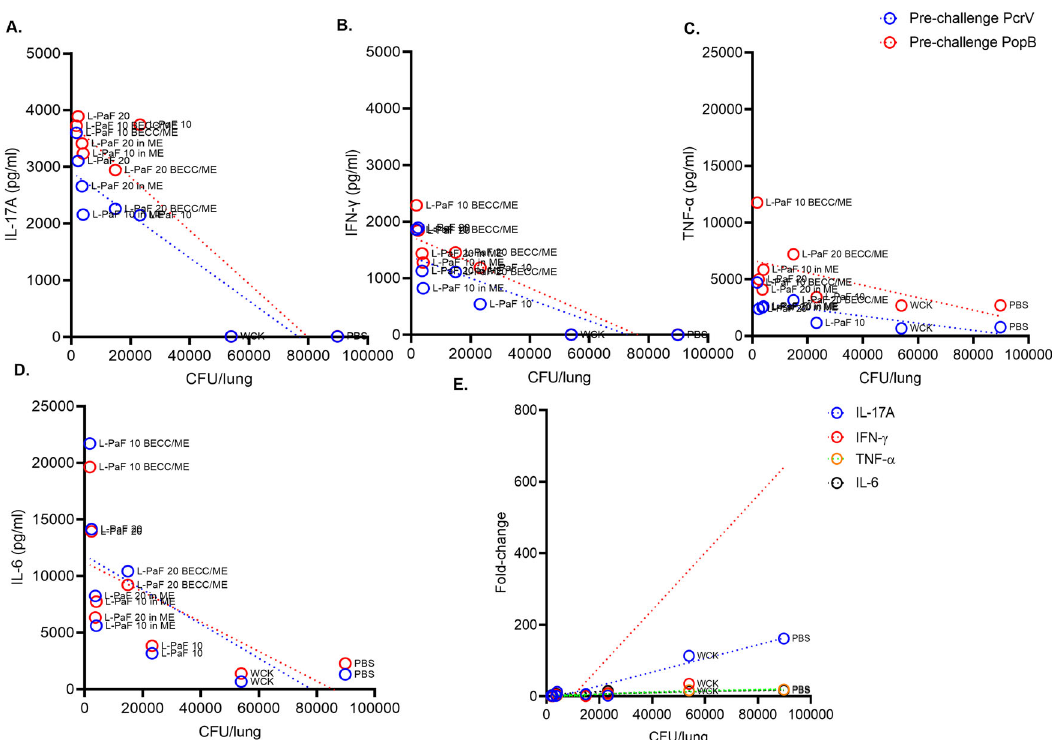
Fig. 5 Correlation between lung burden and lung cytokines. Cytokine determination assays were performed to allow for identi fi cation of potential correlations between Pa lung burden and PcrV- or PopB-stimulated pre-challenge lung cytokines (IL-17A ( A ), IFN- γ ( B ), TNF- α ( C ) and IL-6 ( D )). Fold changes between pre- and post-challenge untreated lung cytokines were evaluated to analyze the correlation with lung burden ( E ). Pearson ’ s r coef fi cient and simple linear regression (95% con fi dence level) were calculated. The exact values can be found in Supplementary Tables 3, and 4. The separation of points in A., B., and C. are readily seen in Supplementary Fig. 3A, B, and C, respectively.